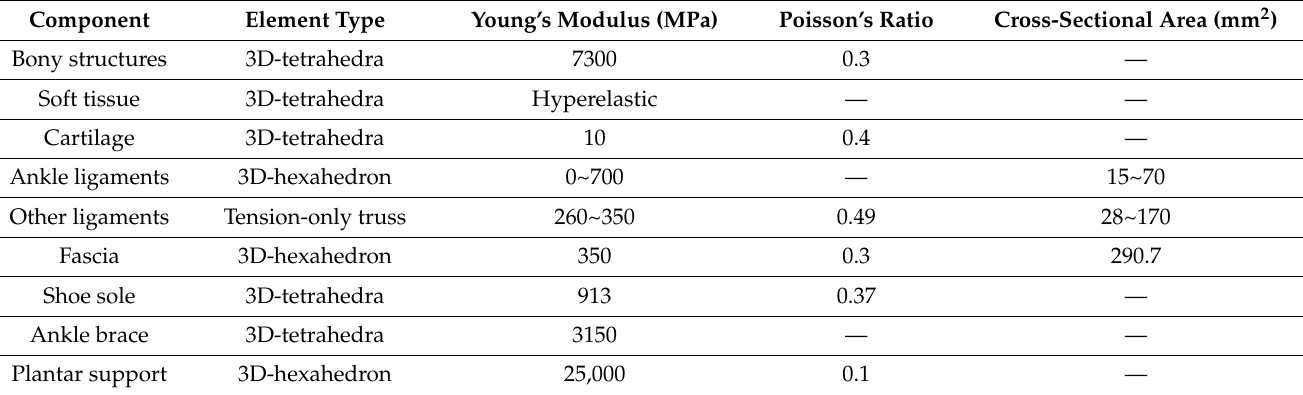
Table 1. Material mechanical properties and element types of components in FE model.